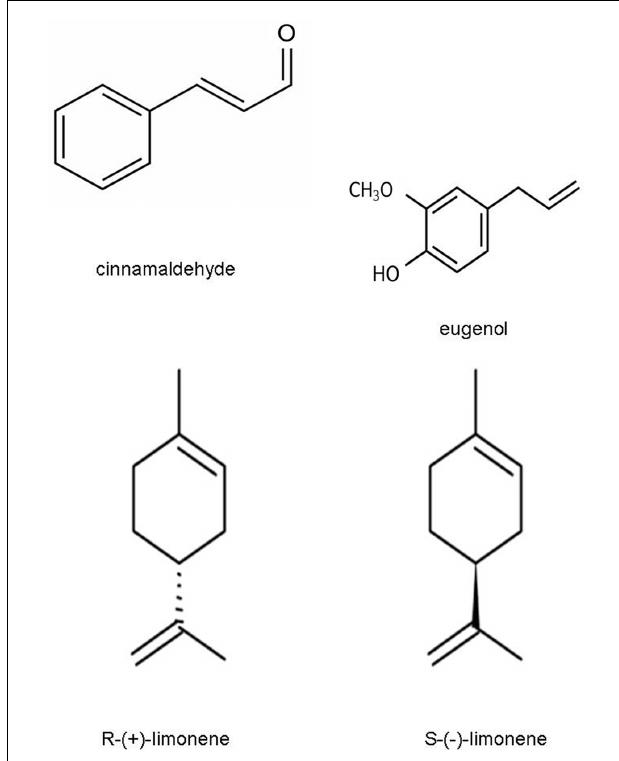
FIGURE 1 | Chemical structure of cinnamaldehyde, eugenol, and limonene.